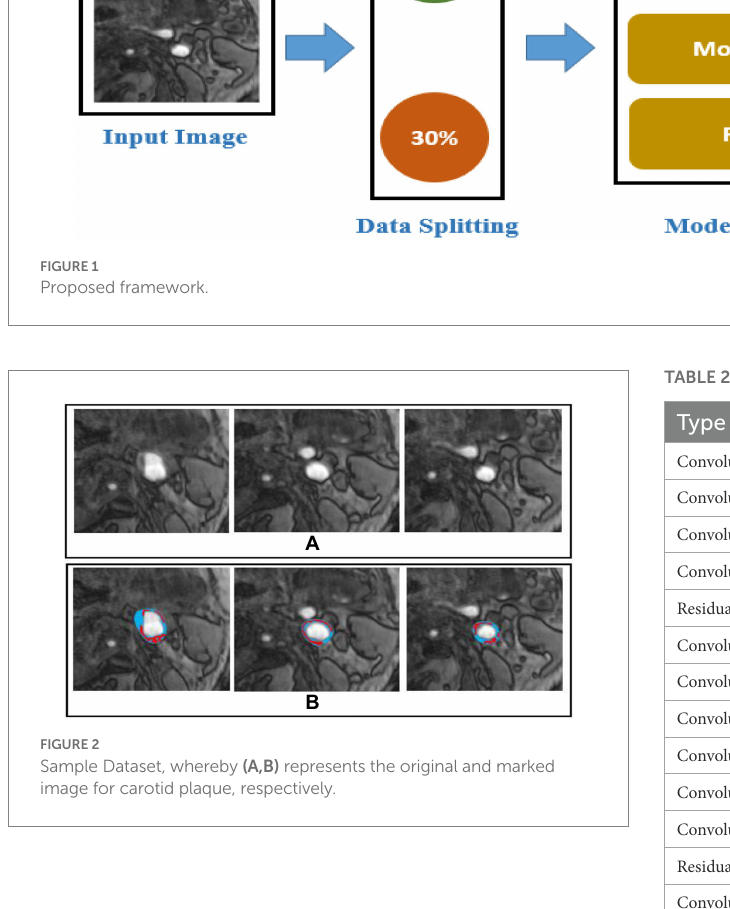
TABLE 1 Detailed statistics of the dataset. Total patients